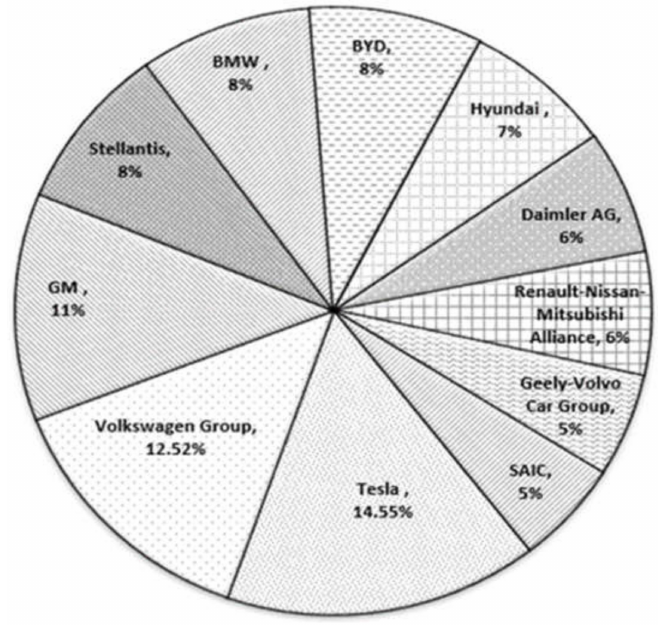
Figure 6. The global market share of the main EV brands in Q2